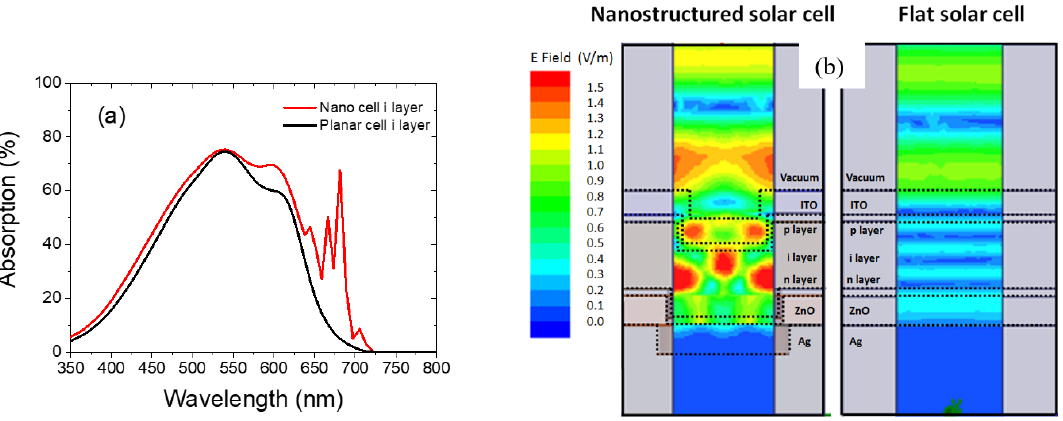
Figure 11. ( a ) Simulated intrinsic amorphous silicon absorption; ( b ) E field distribution of nanostructured and planar solar cell at 670 nm.